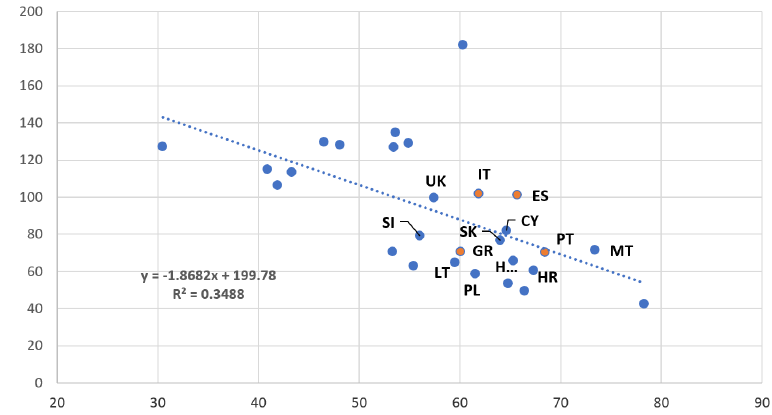
Figure 9: Relation between productivity ( y -axis) and rigid workday schedule ( x -axis), 2010